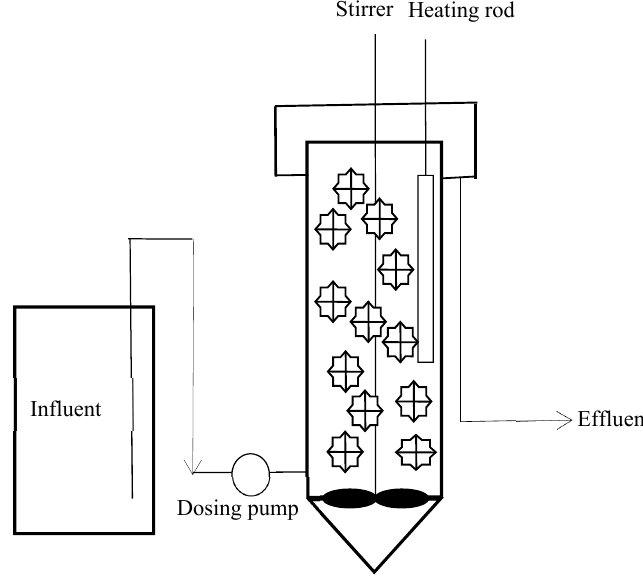
Figure 1. Schematic diagram of the laboratory denitrifying MBBR set-up.